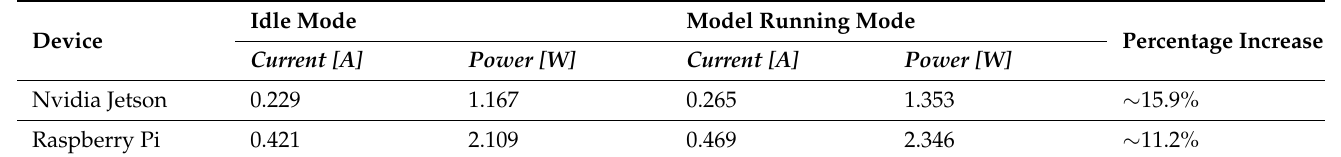
Table 3. Power performance of AI model.